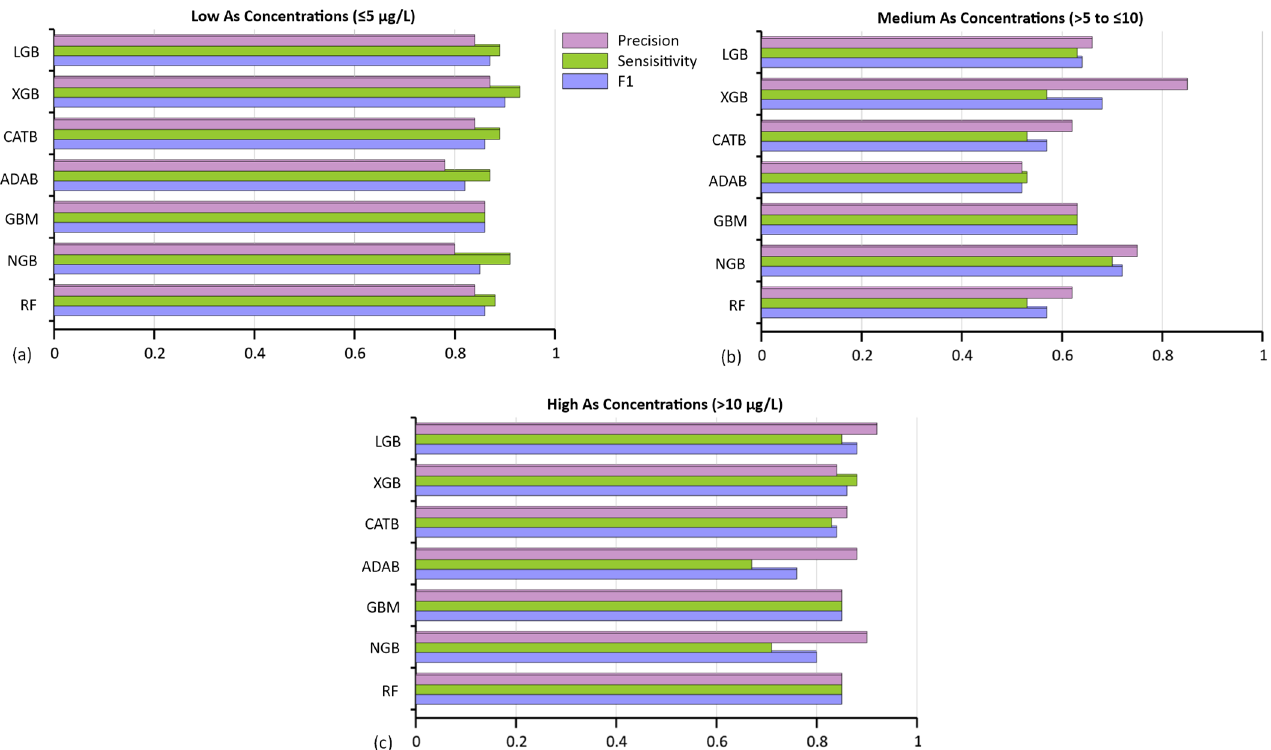
Figure 5. Single-class performance of developed models in classifying: ( a ) low arsenic concentrations; ( b ) medium arsenic concentrations; and ( c ) high arsenic concentrations.